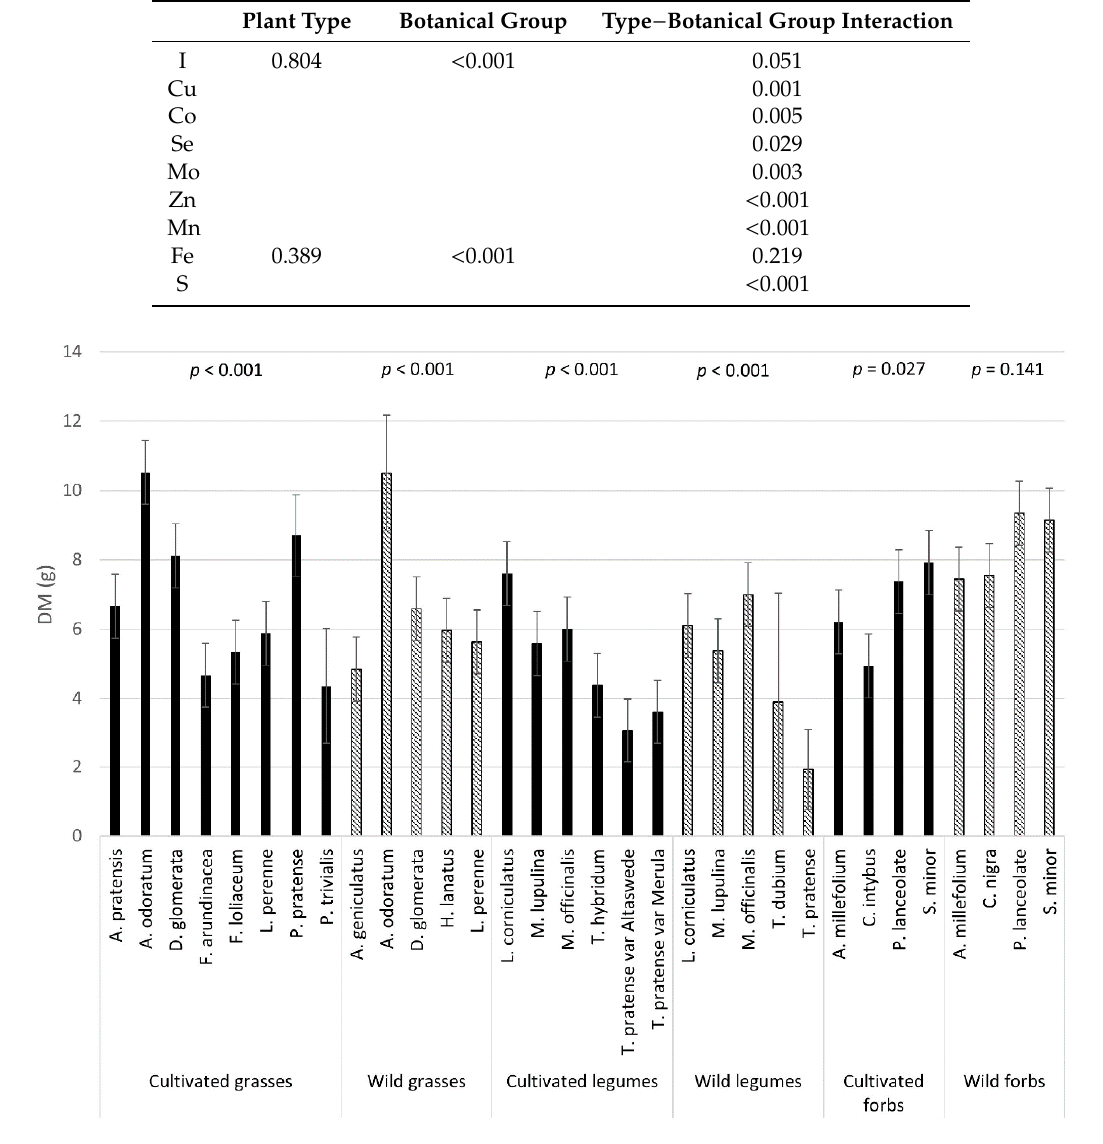
Figure 1. Barchart of means and confidence intervals of the dry matter (DM) yield of pasture species, in mass per pot, split by botanical group and plant type. Error bars show the confidence interval over the five replicates, as given by the LMM analysis. The p -value shows the significance of the di ff erence between species, within plant type and botanical group.